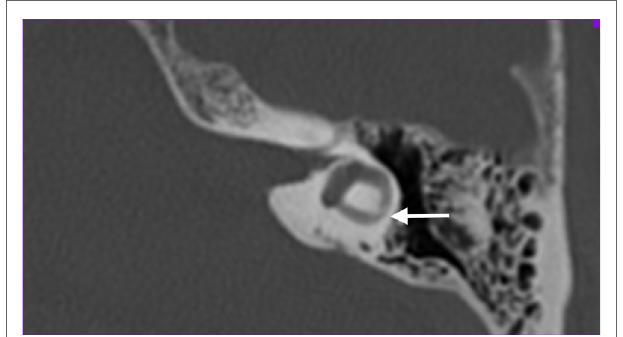
FigUre 1 | axial temporal bone cT-scan of the left labyrinth demonstrating narrowing of the lateral semicircular canal (arrow) .